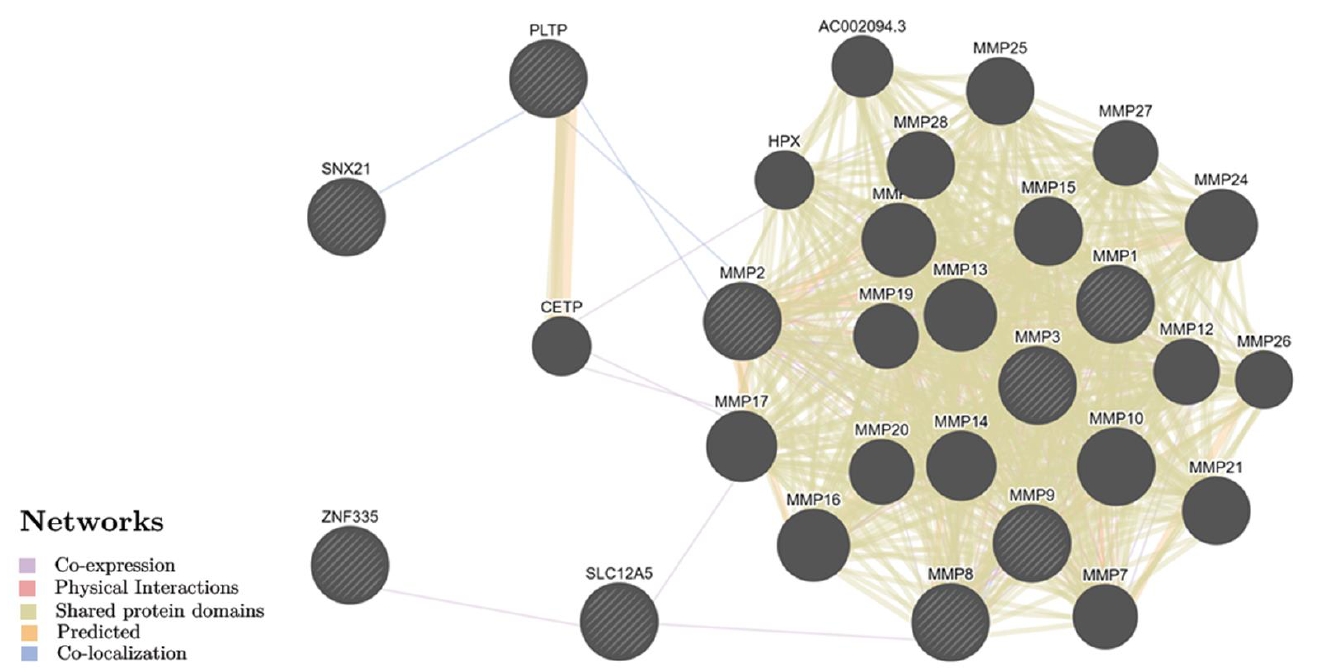
Figure 2. The interaction networks of the candidate genes for breast cancer in various tis- sues/organs inferred using GeneMANIA (http://genemania.org accessed on 18 June 2022). The candidate genes are cross-shaded.